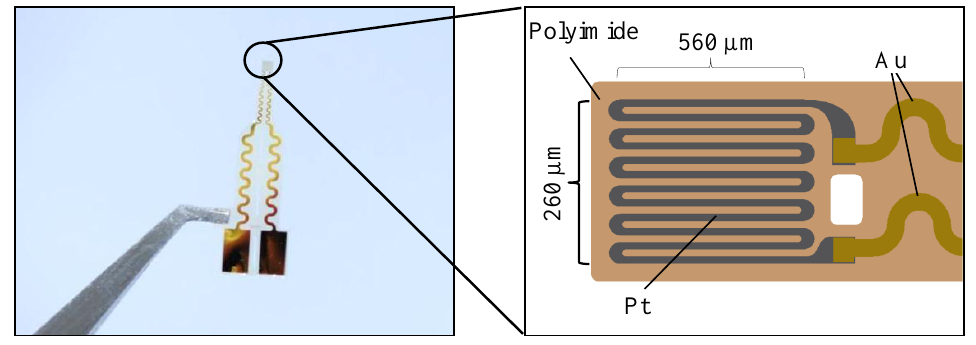
Figure 4. Photograph of a strain gauge and schematic of the meander